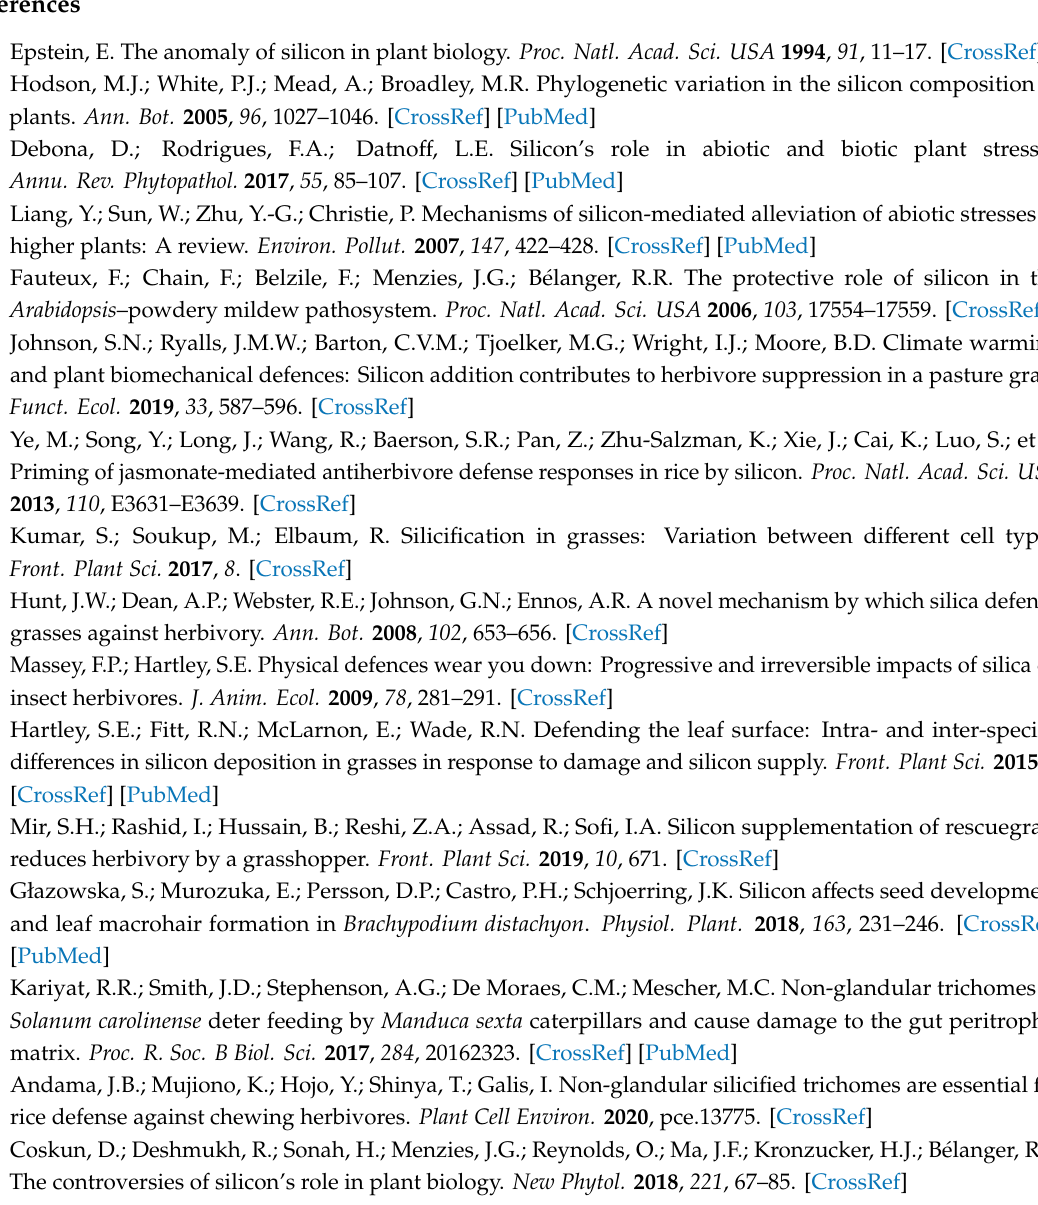
Figure S1: Hydroponics system and dimensions, Table S1: E ff ects of Si and damage level on B. distachyon relative electrolyte